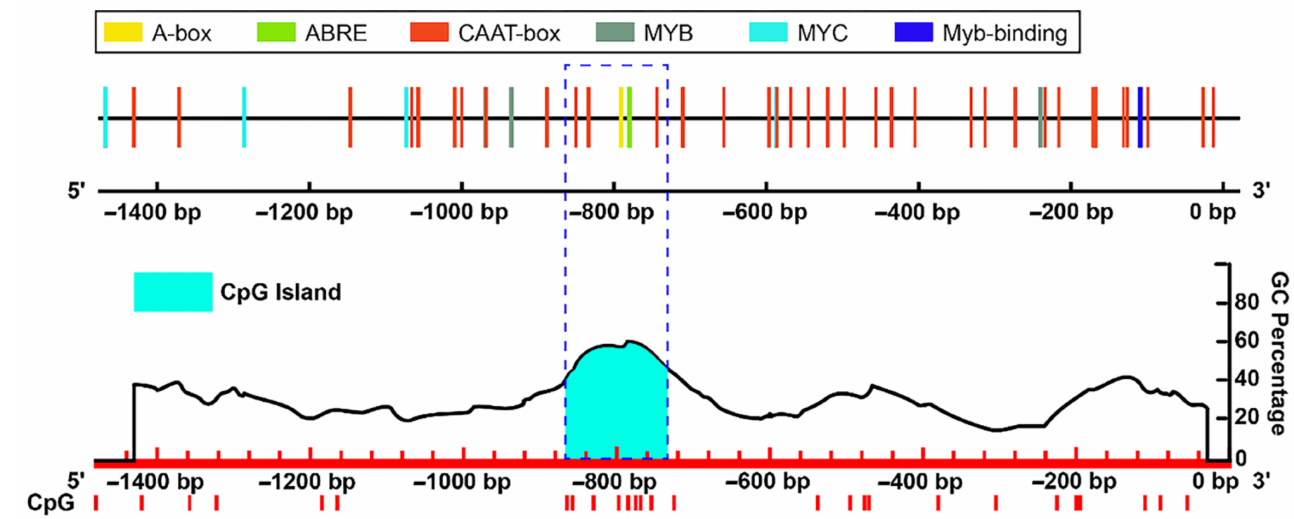
Figure 10. Analysis of glutathione S-transferase gene